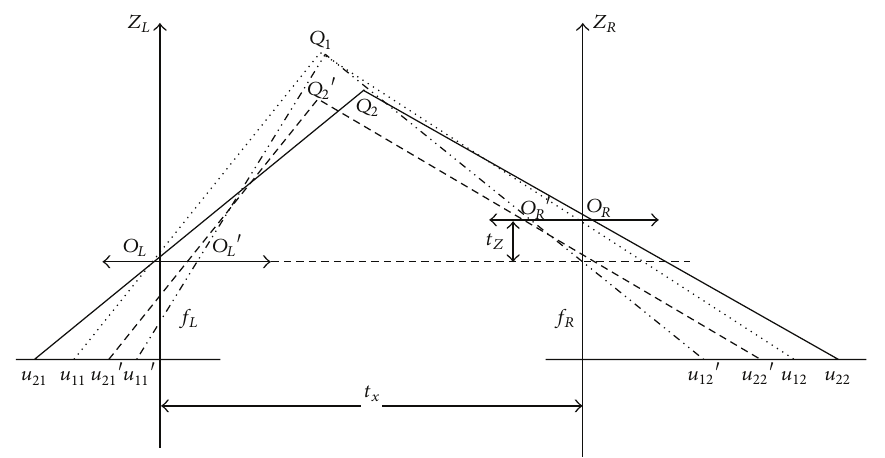
Figure 8: Imaging model of binocular vision